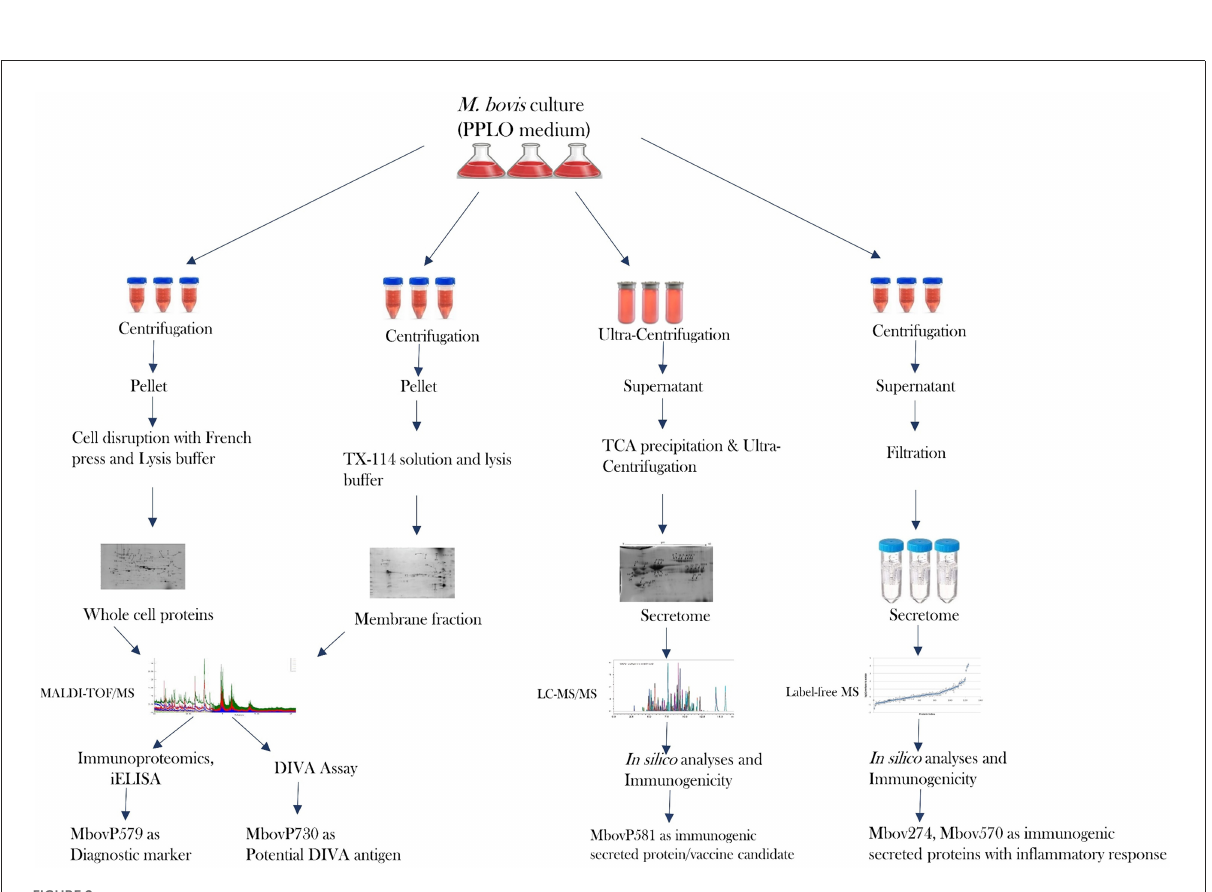
FIGURE2 Recent progress in the proteome and secretome of M. bovis and its